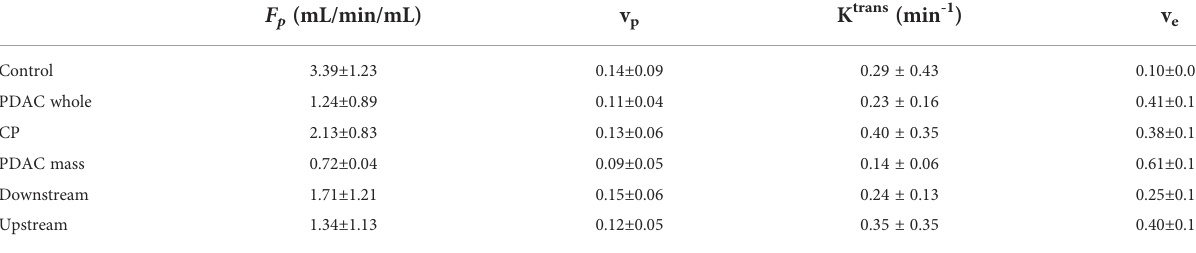
TABLE 2 The mean and standard deviation of F p , v p , K trans , and v e for the six types of tissues.